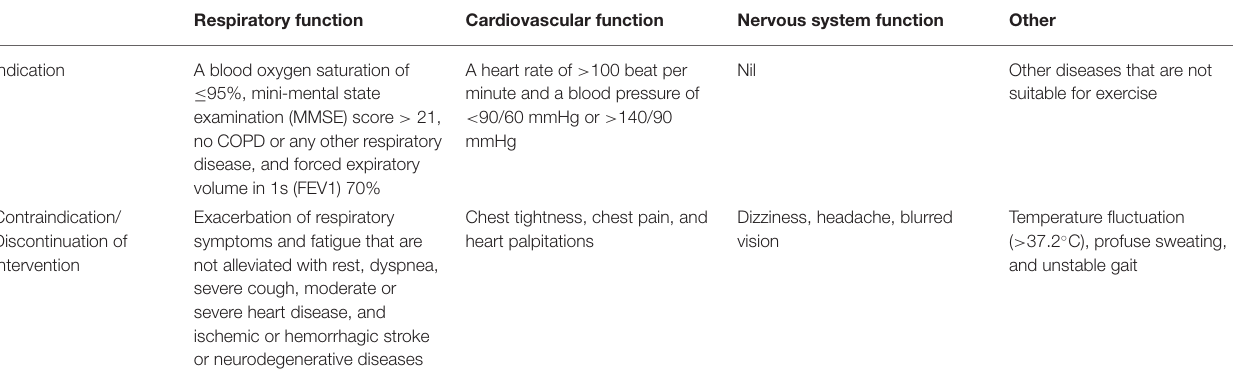
TABLE 3 | Indications and contraindications of chest physiotherapy in patients in after discharge [adopted from (20, 30)]. Respiratory function Cardiovascular function Nervous system